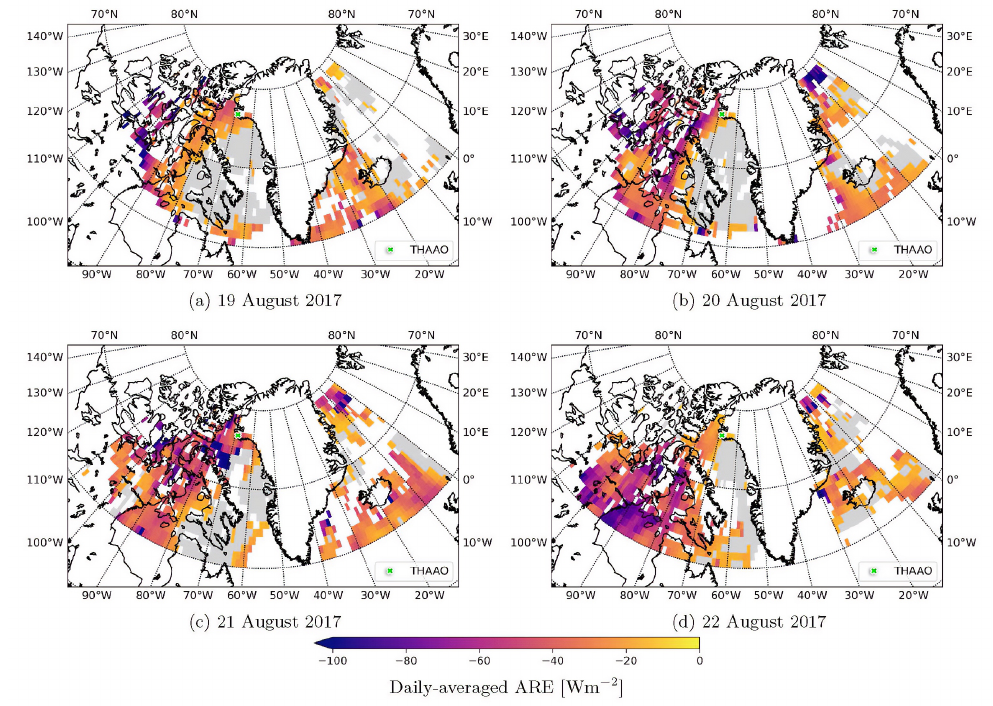
Figure 6. The same as (Figure 5) but for daily-average ARE. White areas represent pixels where no MODIS AOD data were available or data were outside the considered domain. See text for further